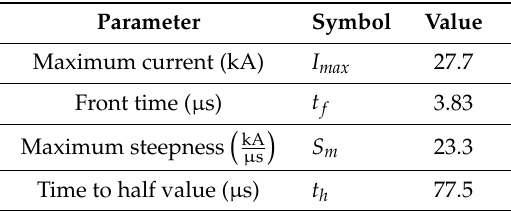
Table 1. Parameters of direct lightning [13].